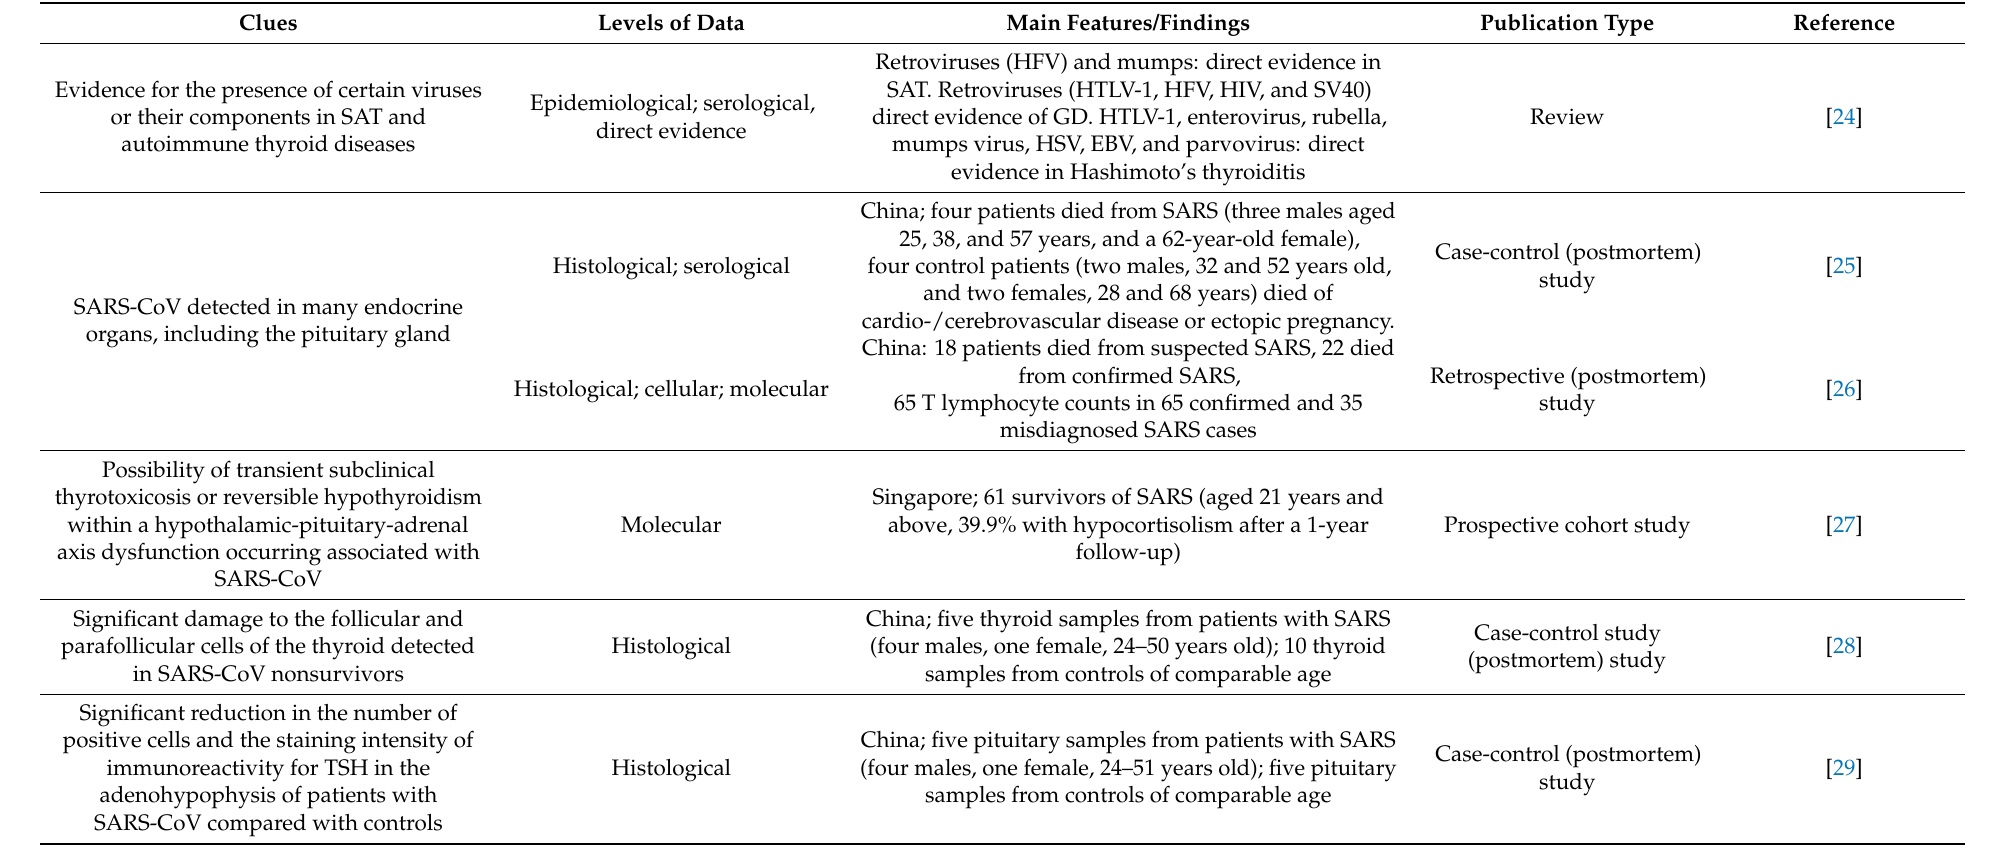
Table 1. Summary of evidence supporting the association between COVID-19 and thyroid